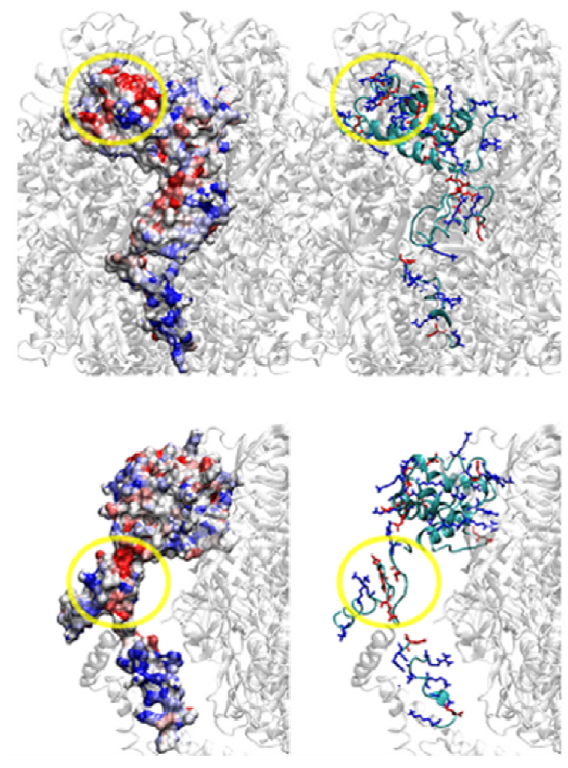
Figure 2. Surface potential regions on OSCP. The two lowest potential regions on OSCP are highlighted by a yellow circle. The average surface atom potential is displayed on the left; the cartoon structure is shown on the right with positively (blue) and negatively (red) charged side chains. The color code for the potential is: saturated red, − 8.0 kJ/(mol·q); saturated blue, 8.0 kJ/(mol·q). The F structure is shown as transparent. The yellow circle 1 in the upper panel is located at OSCP residues E48, D71, E76 and F78. The latter region, discussed in the text, encompasses Helices 3 and 4. For the sake of completeness, the yellow circle in the lower panel is located at the other lowest potential region located at OSCP residues H112, E115, V116, E128 and E133. The surface potential is computed as previously described